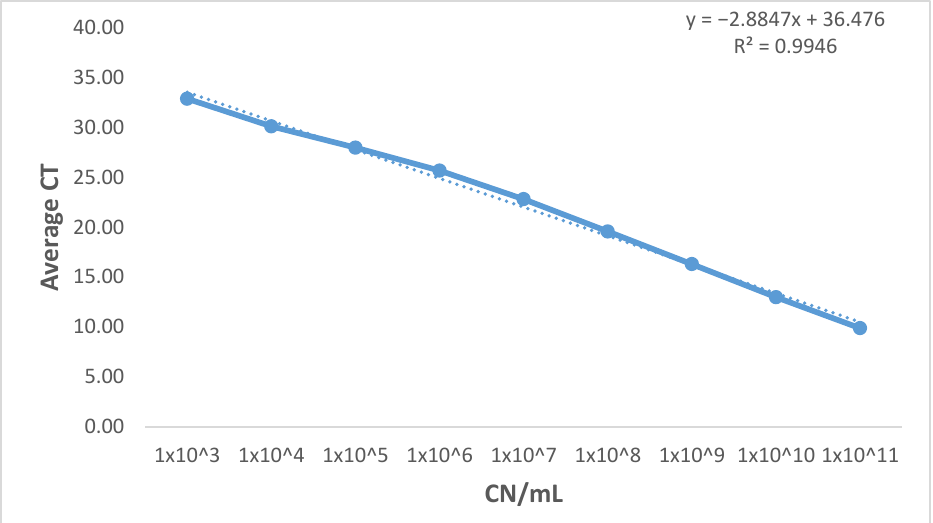
Figure 2. Standard curve of the currently existing ( recA ) qPCR. The standard curve of BA recA qPCR assay was generated by plotting average CT values from three independent runs against log10 of 10 fold serial dilutions (from 10 11 –10 3 ) of plasmid DNA (copy number/mL). Reaction efficiency of 122.16% was estimated using the standard curve slope. Table 5. Intra- and inter-assay variations in different concentrations of positive control DNA of the three